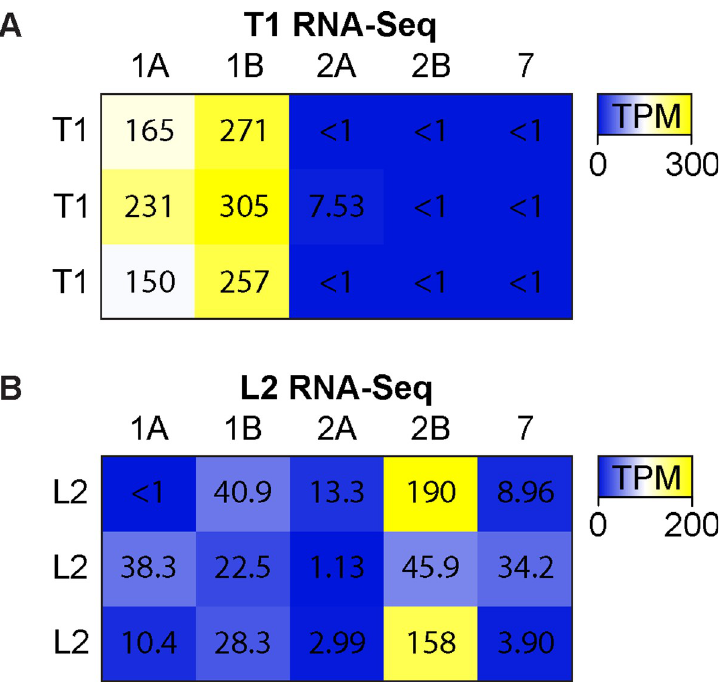
Fig 2. L2 neurons express 5-HT2B and T1 neurons express both 5-HT1A and 5-HT1B serotonin receptors. T1 or L2 neurons were isolated by FACS for RNA-Seq. Transcript abundance was calculated as Transcripts Per Kilobase Million (TPMs). ( A ) T1 RNA-Seq TPMs (color low to high, blue to yellow) were higher for 5-HT1A and 5-HT1B compared to other serotonin receptors. ( B ) L2 RNA-Seq showed high abundance 5-HT2B in two of three samples, with 5-HT2B being the most abundant serotonin receptor transcript in all